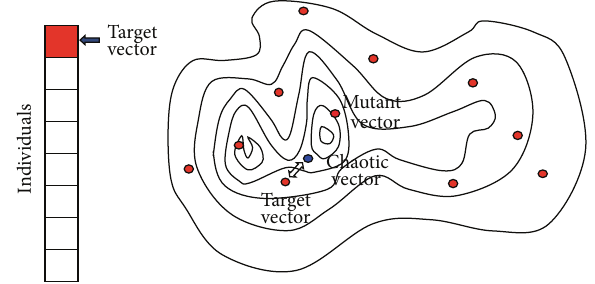
Figure 1: Chaotic evolution algorithm framework; there are three special vectors in chaotic evolution algorithm, a target vector that is an individual in the population, a mutant vector that simulates the chaotic motion from a chaotic system, and a chaotic vector that is made by conducting crossover operation on a target vector and a mutation